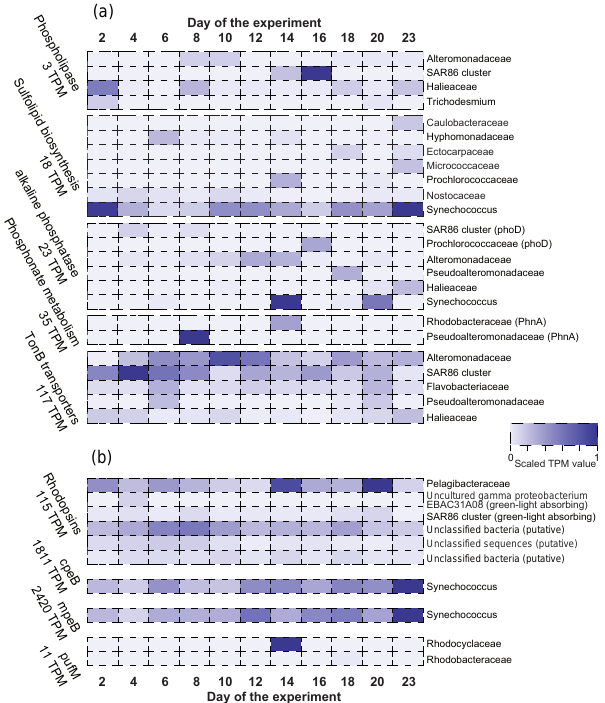
Figure 7. Heat map showing selected genes indicative for different phosphorus acquisition strategies (a) and genes for light-absorbing proteins (b) . TPM counts were summed up per taxonomic fam- ily, the names of which are denoted to the right of each line. The maximum TPM value for each group is written below the name of that group. For plotting, values were scaled within each functional group, but not for each line, resulting in the maximum color density always representing the maximum TPM. After the name, in brack- ets, is additional annotation information, if deviant from the name of the functional